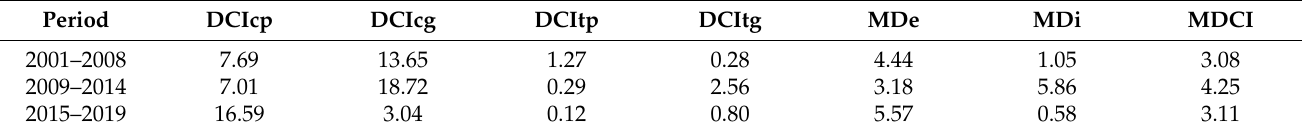
Table 2. Cross DCI and improved Dynamic Concentration Index at each